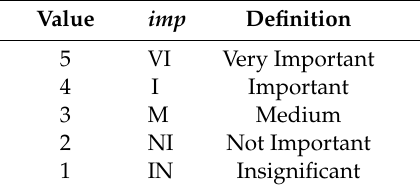
Table 4. Predicted importance classification and scale.